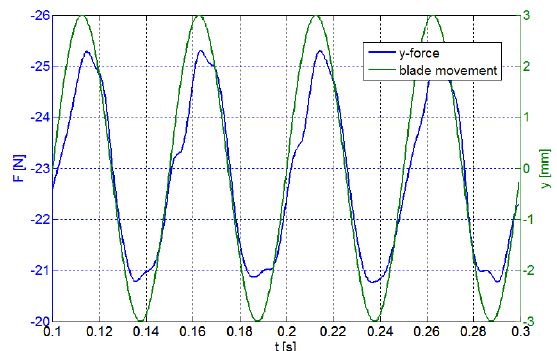
Fig. 6. Pressure contours at time t = 0 . 1345s, where the middle plate reaches a lowest displacement. Fig. 3. Detail of computational mesh in the vicinity of simplified cascade.